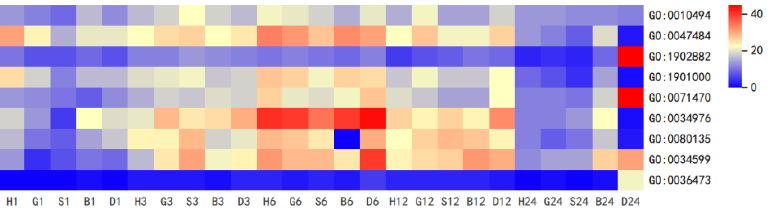
Figure 2. GO enrichment analysis of stress response to spraying treatments at 1, 3, 6, 12, and 24 h. Heat map represents the DEGs numbers (H, H 2 O treatment; G, GSH treatment; S, GSSG treatment; B, BSO treatment; D, DTT treatment).